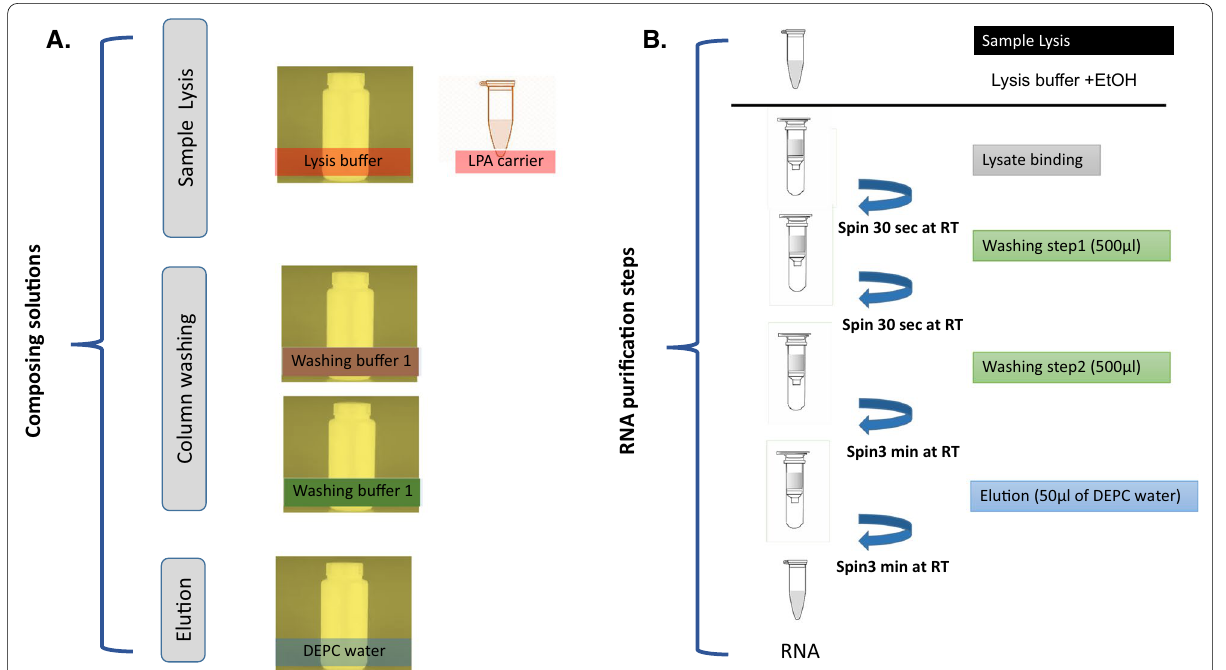
Fig. 1 Experiment flow chart of viral RNA purification. A kit solutions. B procedure